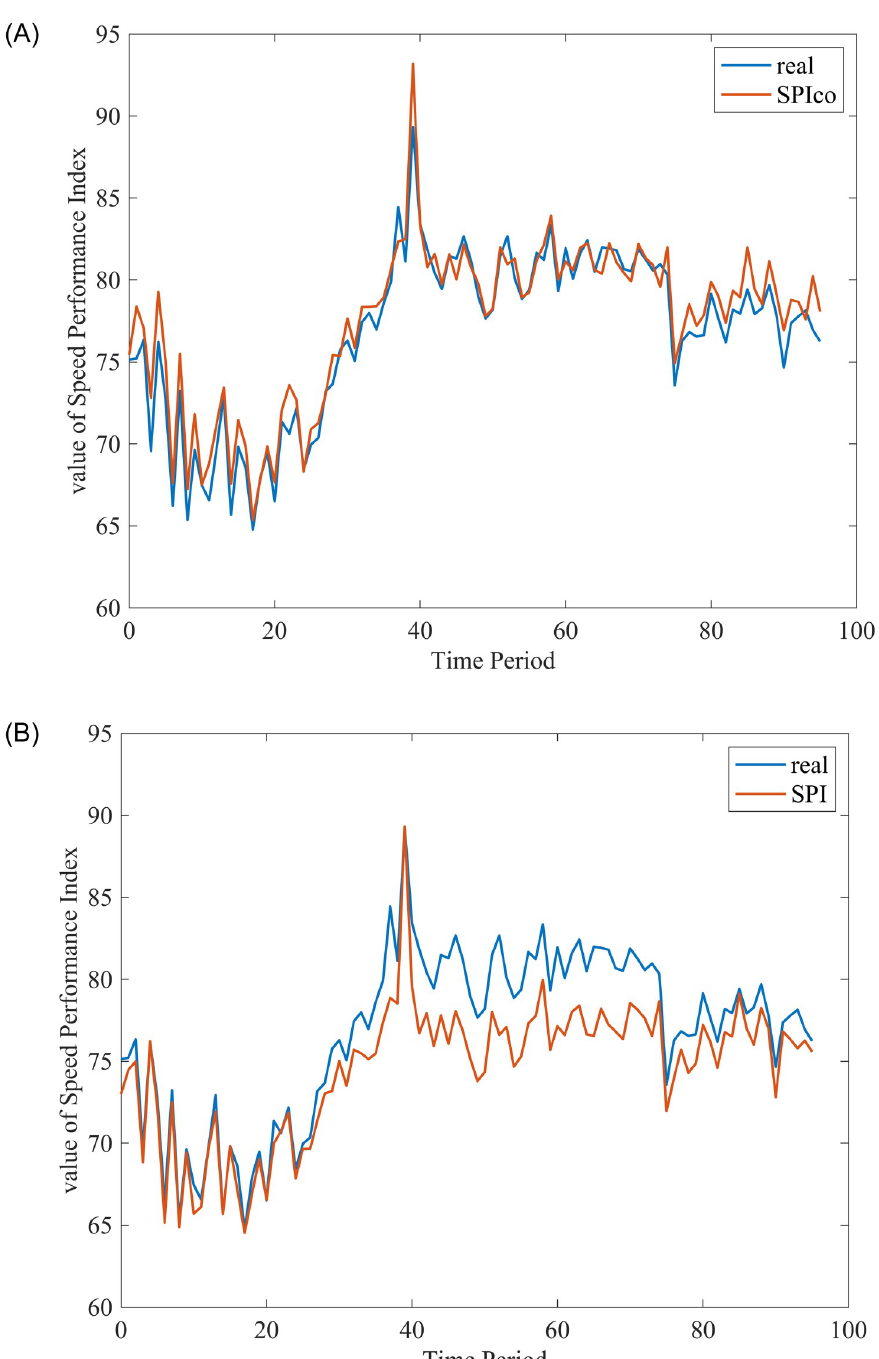
Fig 12. Comparison before and after adding the correction term. A: Comparison before adding the correction term. B: Comparison after adding the correction term.